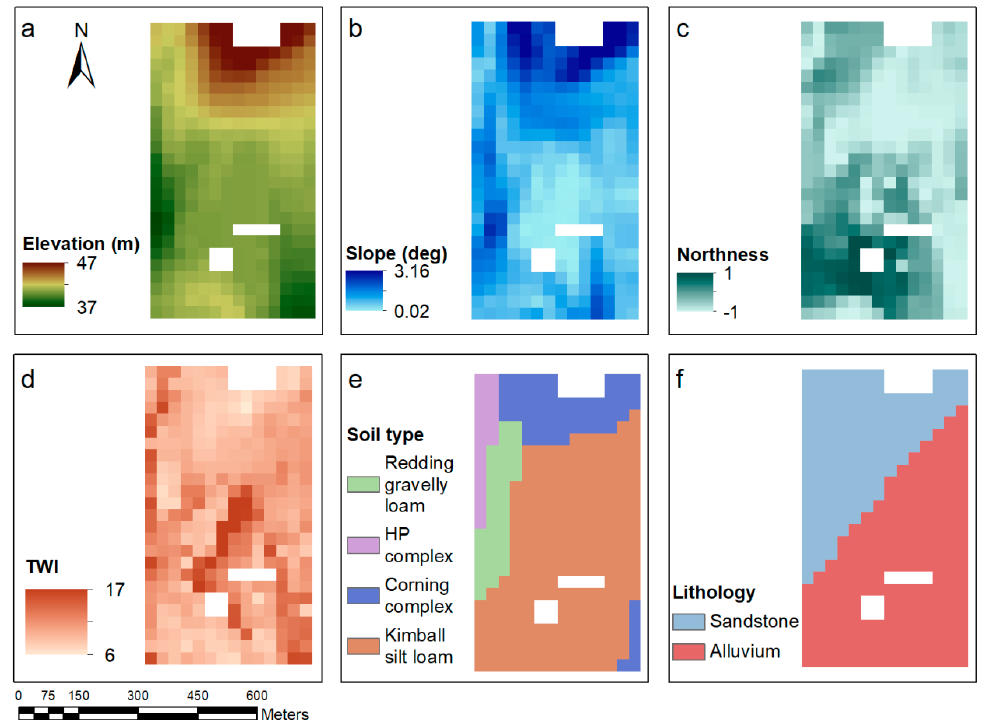
Figure 3. Environmental variables within the vineyard: ( a ) Elevation; ( b ) Slope; ( c ) Northness; ( d ) Topographic wetness index (TWI); ( e ) Soil type (HP stands for Hadselvill-Pentz complex); and ( f ) Lithology.